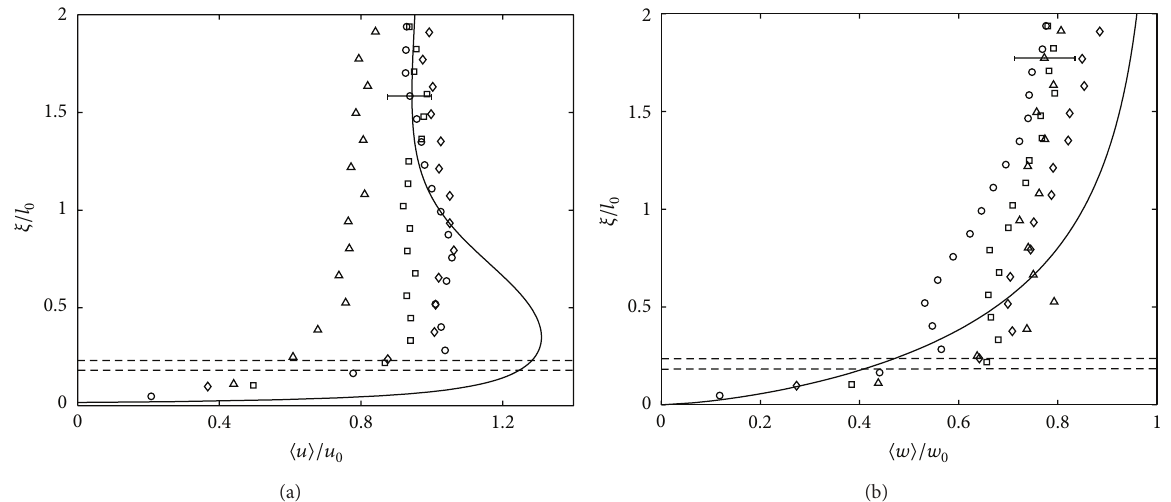
Figure 6: Plots showing measurements of (a) ⟨𝑢⟩/𝑢 0 and (b) ⟨𝑤⟩/𝑤 0 against dimensionless distance above the tank base 𝜉/𝑙 0 . The data shown correspond to 𝑅𝑒 𝑙 = 95 ( ∘ ), 𝑅𝑒 𝑙 = 76 ( ◻ ), 𝑅𝑒 𝑙 = 74 ( 󳵻 ), and 𝑅𝑒 𝑙 = 113 ( ⬦ ). To avoid saturation, a single error bar has been included in each plot which is representative of the variability observed in all of the data shown. The theoretical curves for both r.m.s horizontal and velocity components are included for comparison, shown here as solid